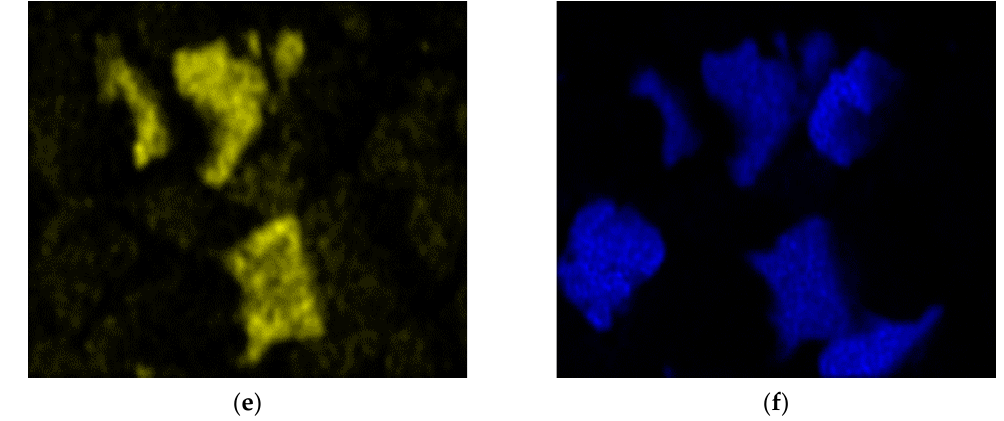
Figure 10. Distribution of the elements: ( a ) fraction 4; ( b ) distribution of elements on the surface; ( c ) zirconium; ( d ) phosphorus; ( e ) iron; ( f ) titanium.